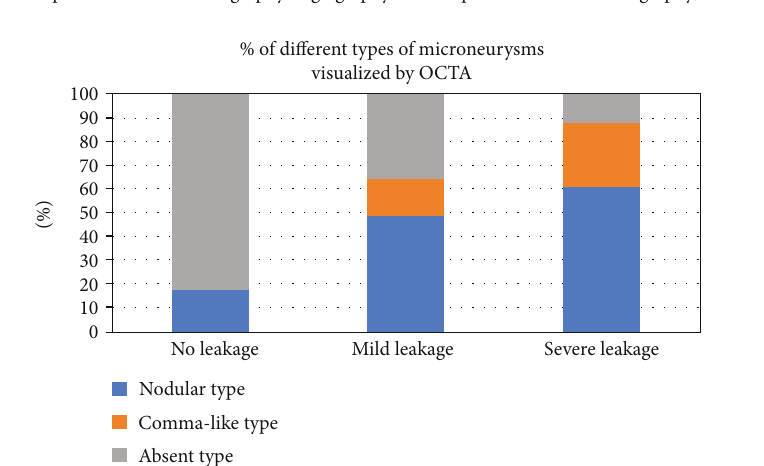
Figure 8: Percentages of di ff erent types of microaneurysms visualized by OCTA in di ff erent fl uorescein leakage groups. OCTA: optical coherence tomography